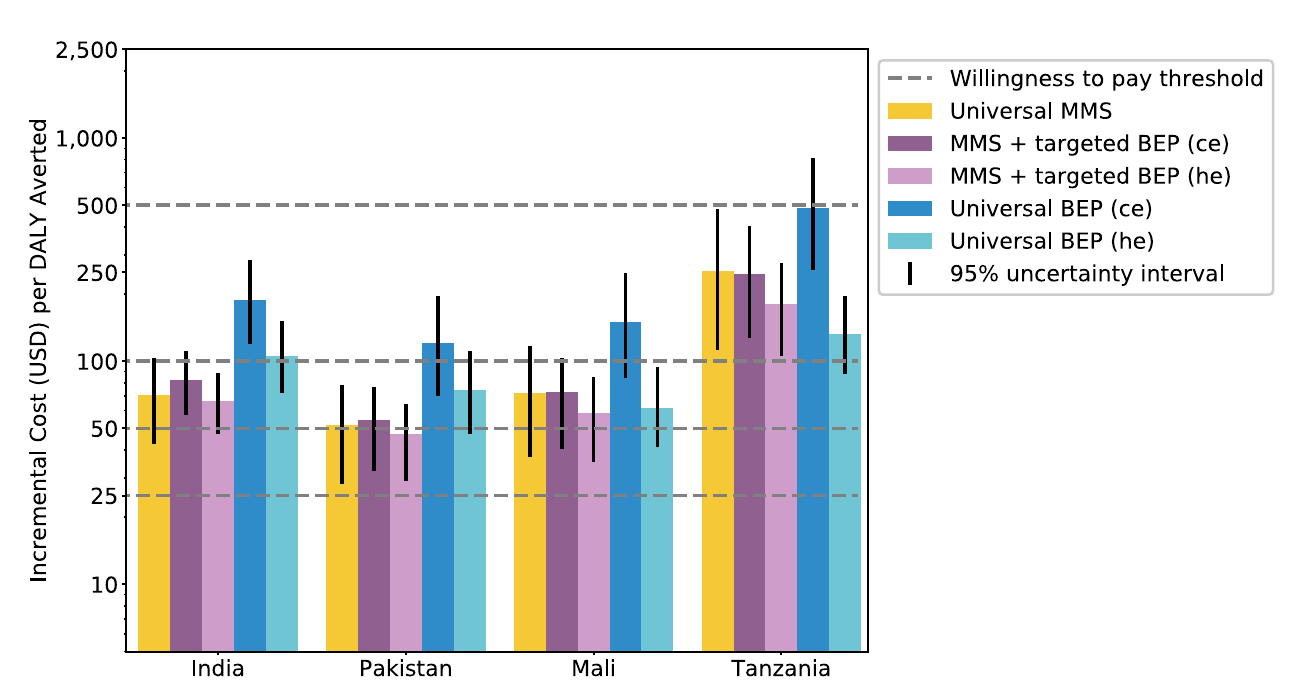
Fig 5. Incremental cost per DALY averted among the first 2 years of life in each modeled location for each simulated scenario relative to the baseline scenario (log-scale). BEP, balanced energy protein; ce, scenarios with current evidence effects for BEP; DALY, disability-adjusted life year; he, scenarios with hypothesized effects for BEP; MMS, multiple micronutrient supplementation.